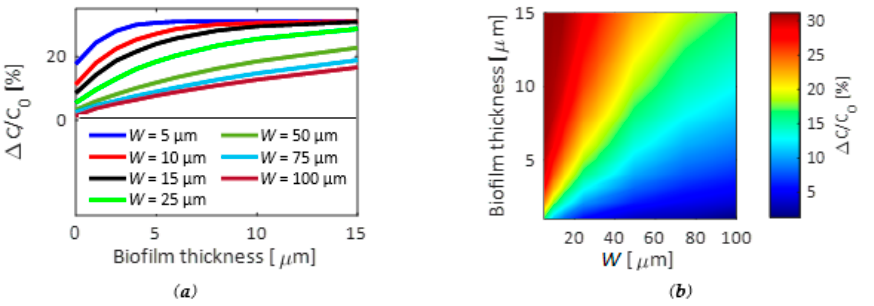
Figure 6. ( a ) Change of the capacitance Δ C/C 0 = ( C’ − C 0 )/C 0 in the IME structure for different values of thickness of the bacterial biofilm as a function of the electrode width ( W = G ); ( b ) Change of the capacitance Δ C/C 0 as a function of the electrode width calculated for different values of the biofilm thickness.